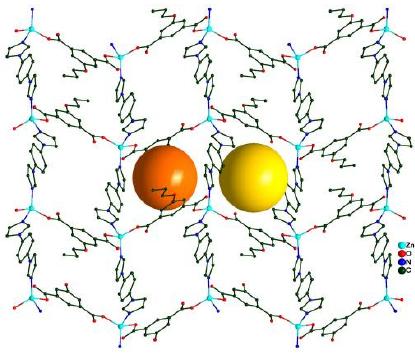
Scheme 1. The coordination modes of 5-PIA and imbm ligands in complex 1 . Figure 2. View of the 3D framework of complex 1 parallel to the a -axis.